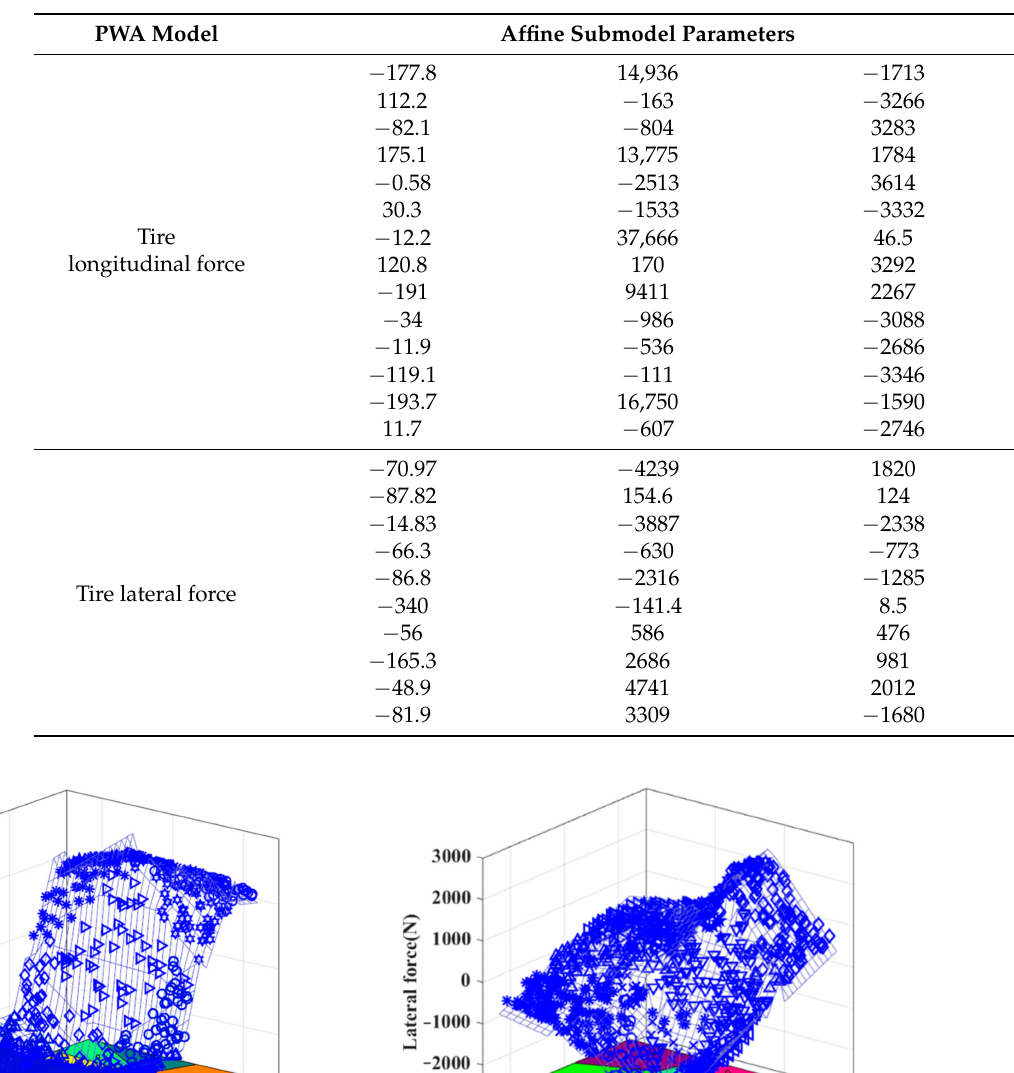
Table 2. Parameters of each affine submodel.